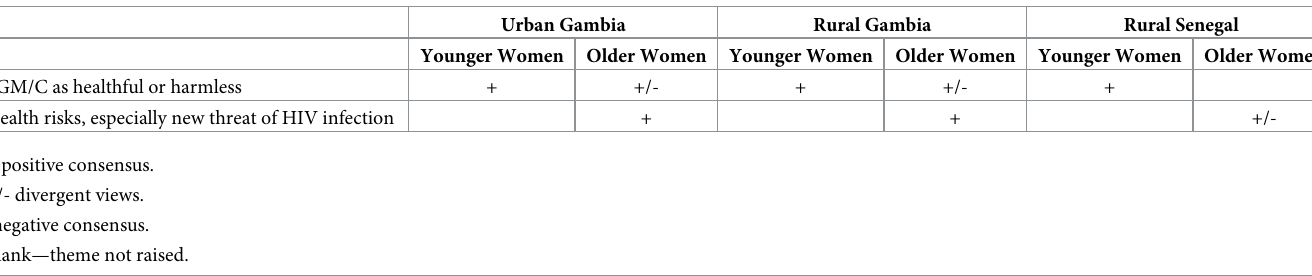
Table 4. Summary matrix of themes related to the overarching theme of